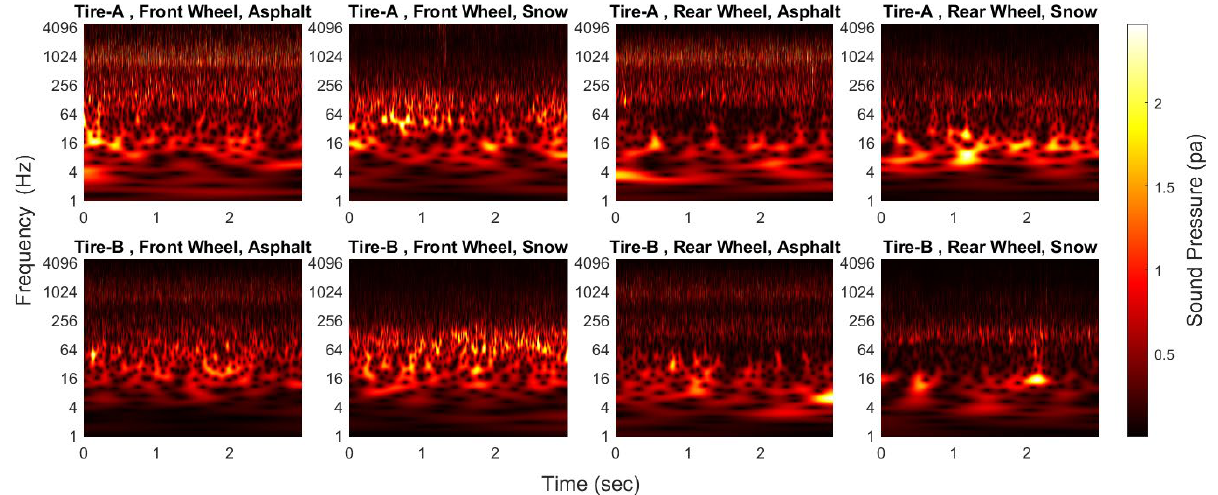
Figure 9. Time-scale analysis for the TPIN signals measured by microphones.